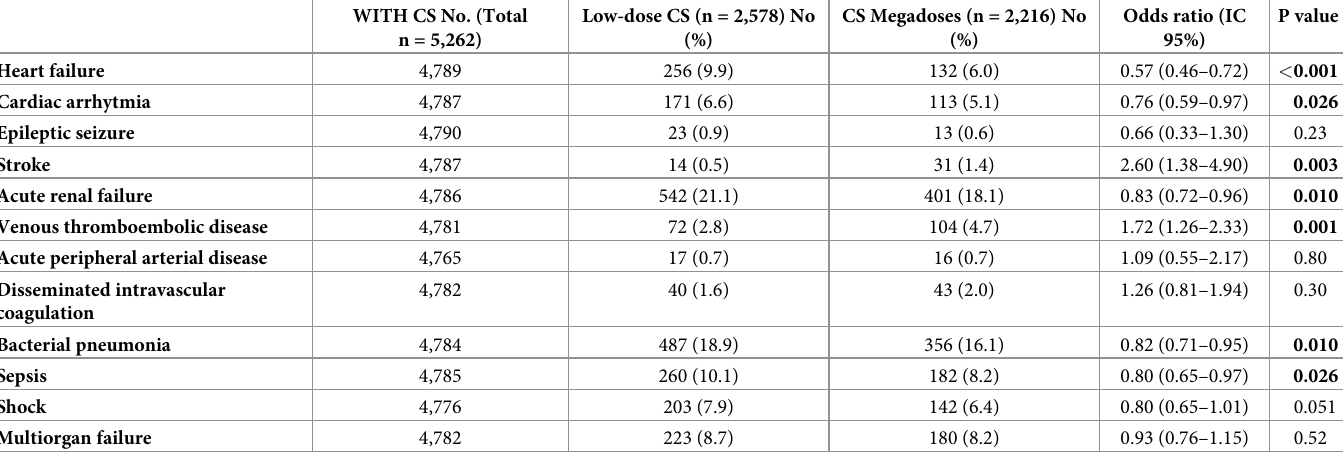
Table 4. Development of complications in patients with CS.